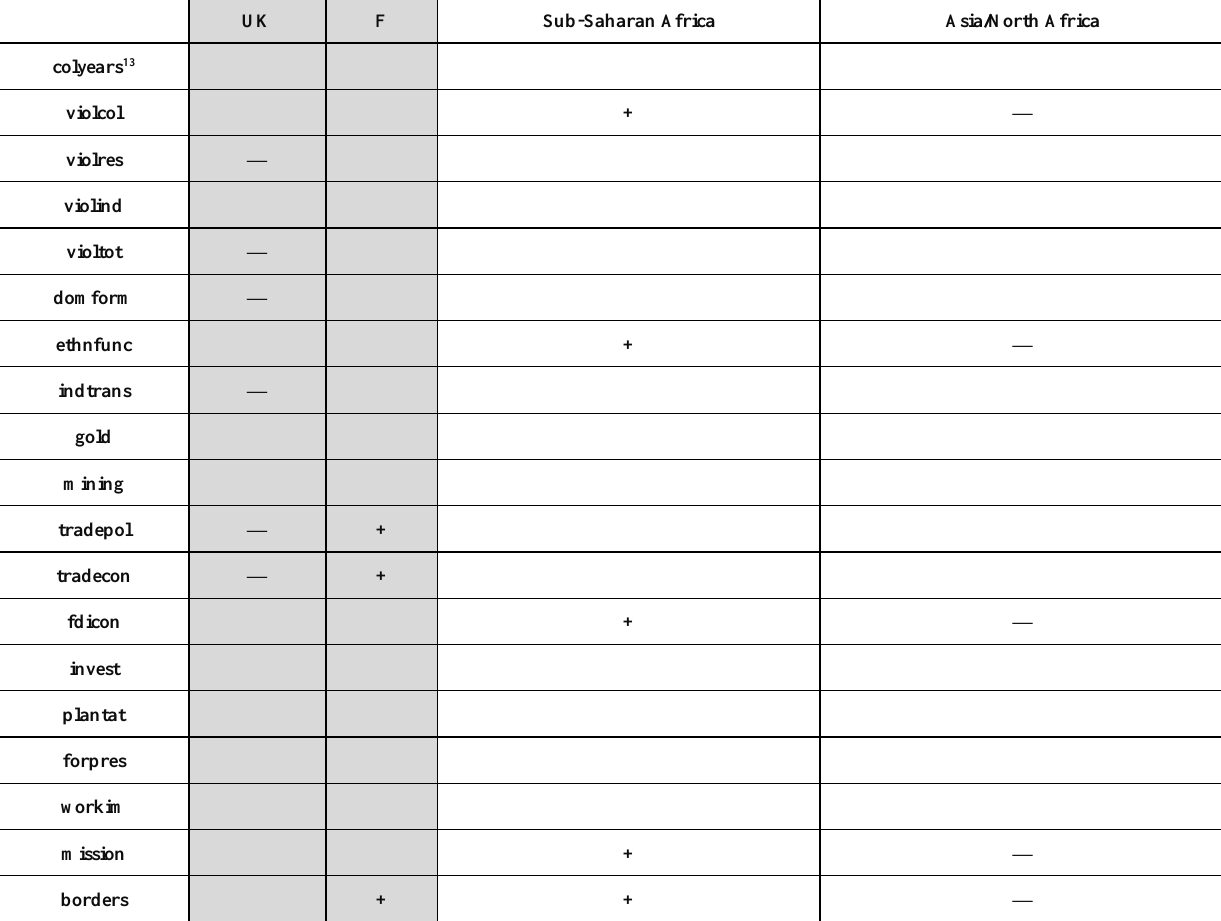
British vs. French colonies: N= 75 (without semi-colonial countries and shared colonies). Sub-Saharan African vs. Asian/North African colonies: